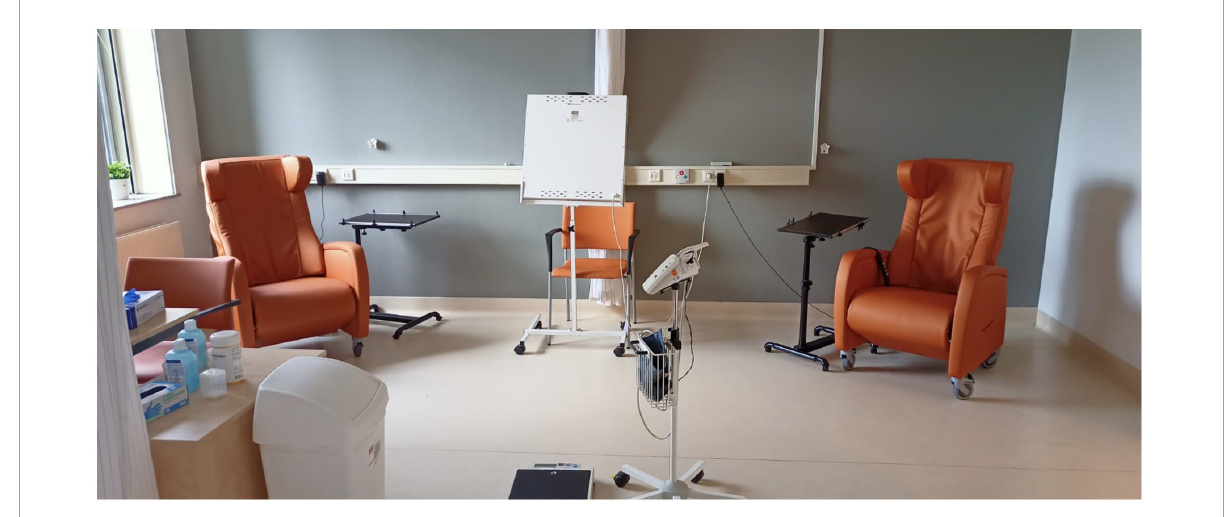
FIGURE1 Room at the outpatient clinic (UMCG) used for (occasionally parallel) esketamine